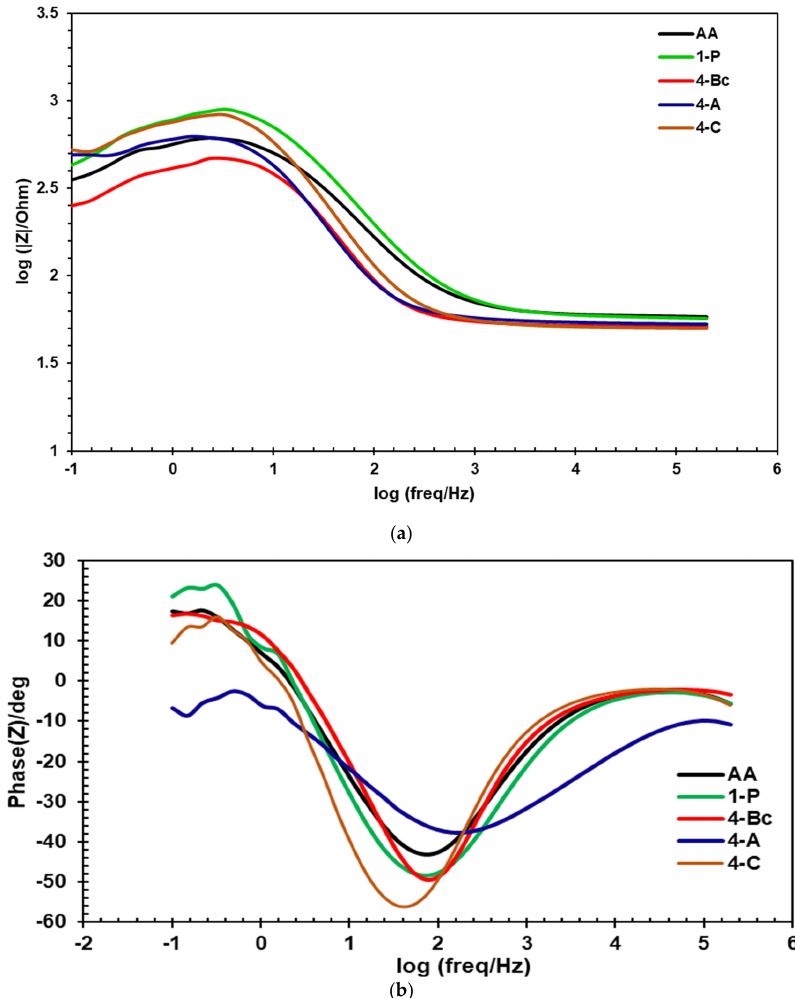
Figure 11. ( a ) Bode plot, ( b ) Bode plot phase angle of ZK30 alloy before and after ECAP processing.